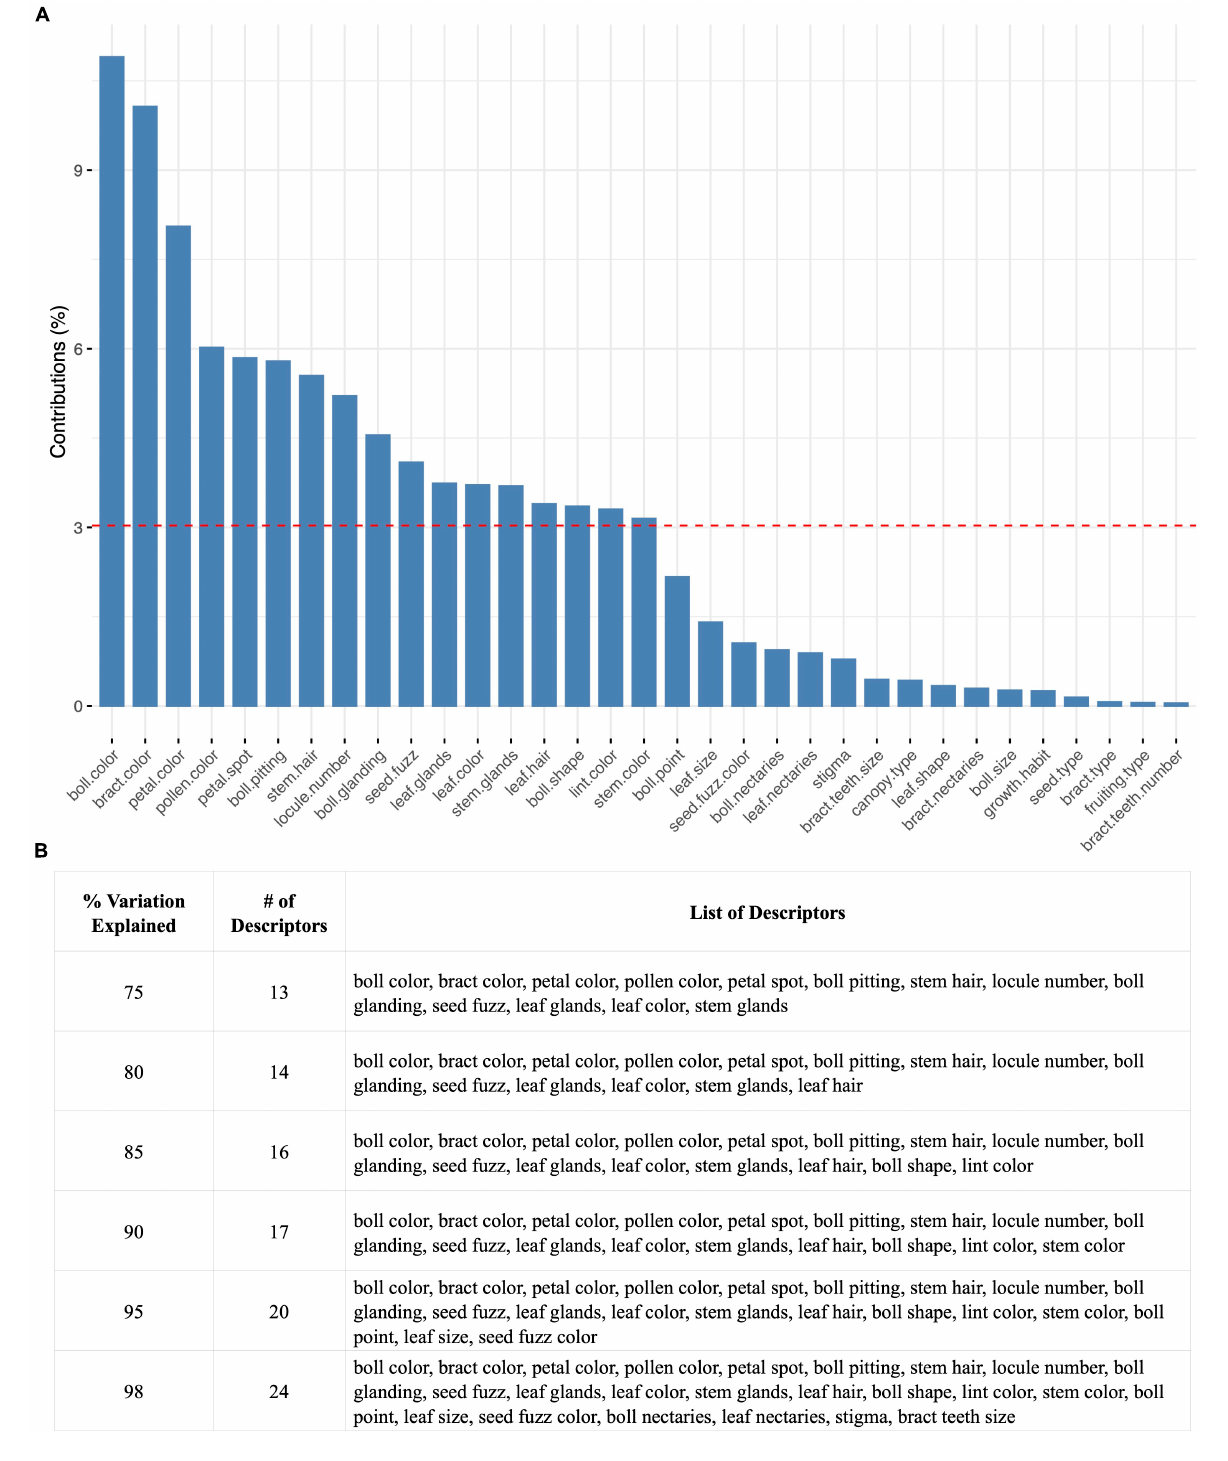
FIGURE 9 | Descriptor contribution across the SA, TEX, and Gb groups. (A) Overview of the percent variation contributed to the overall dataset per categorical descriptor. (B) Group of categorical descriptors required to capture 75, 80, 85, 90, 95, and 98% of the overall dataset.